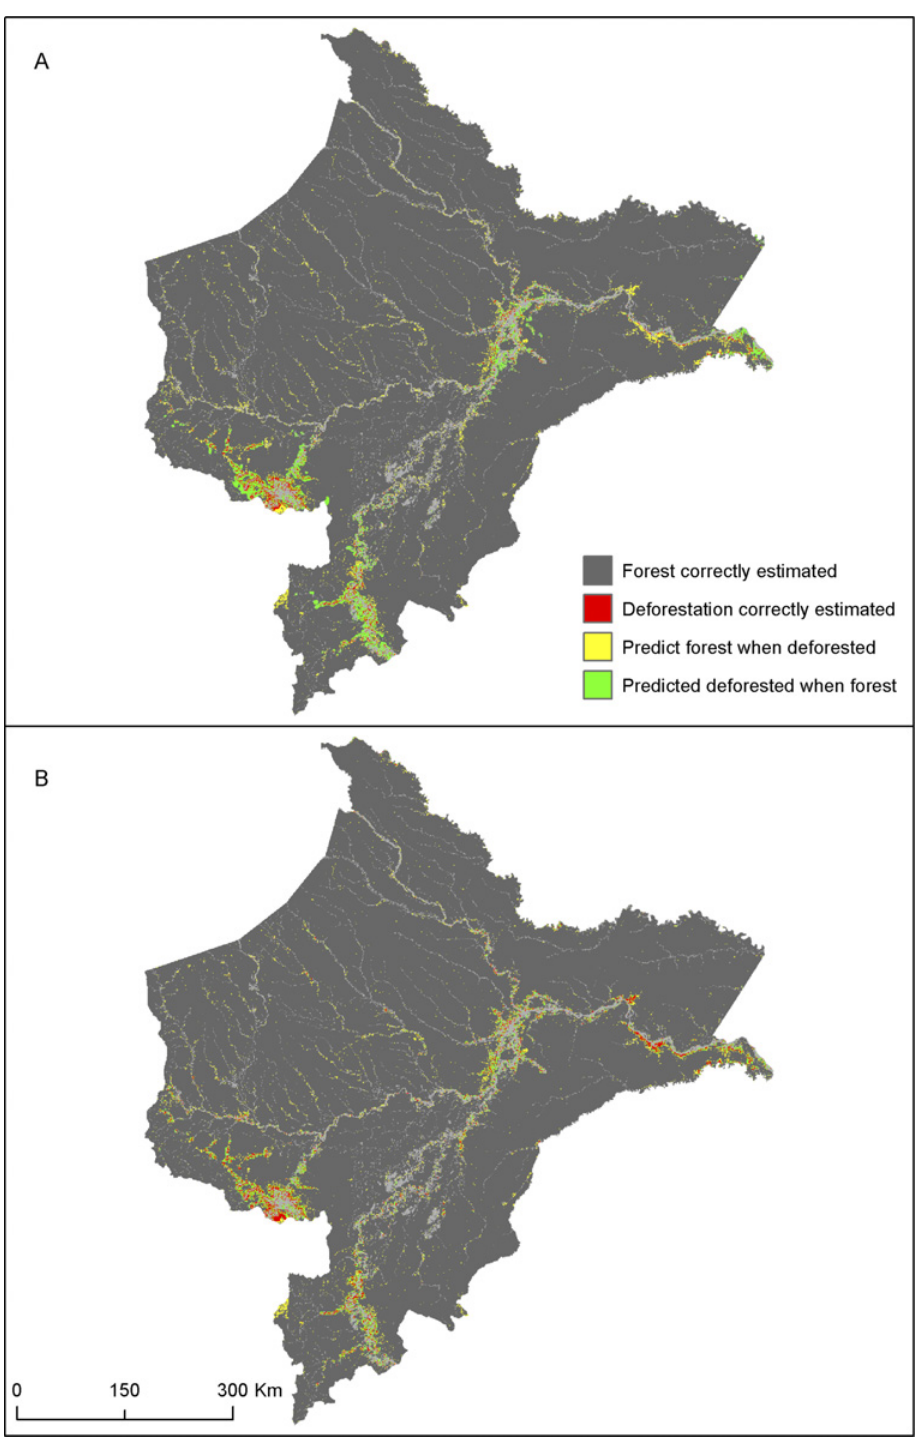
Fig 3. Cross tabulation of actual vs. predicted deforestation. NSP1 Model. (B) SLS1 Model spatial allocation of deforestation is superior to the NSP1 Model.